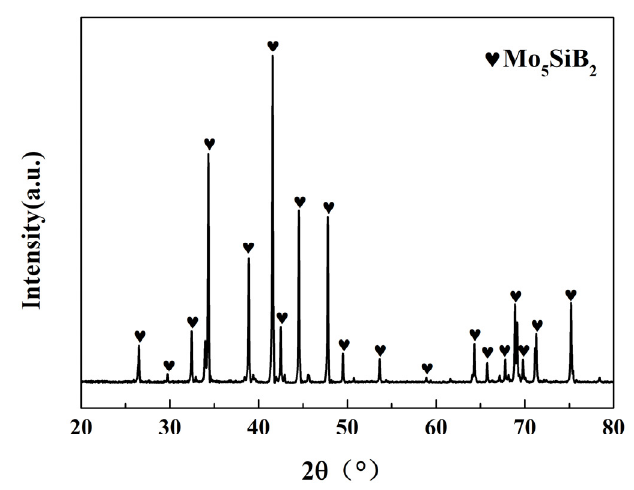
Figure 3. XRD pattern of the obtained Mo 5 SiB 2 powder.